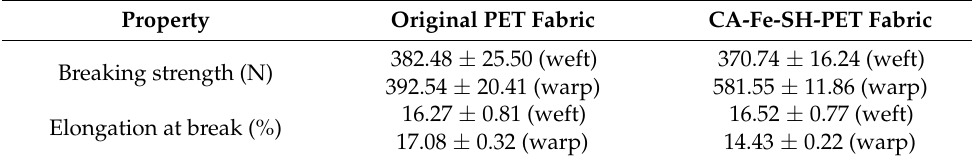
Table 2. Breaking strength and elongation at break of PET